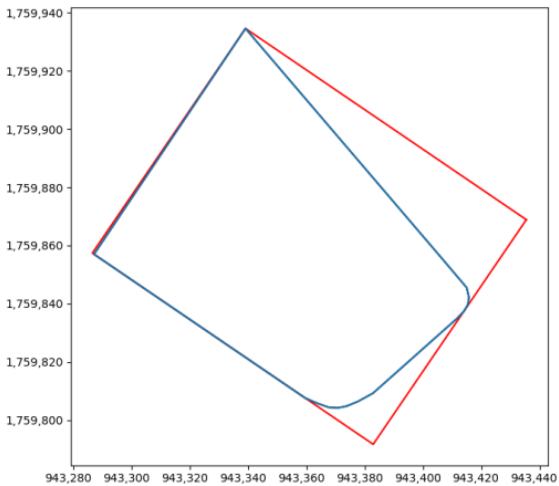
Figure 2. MBR (red area) for the given land (black area).